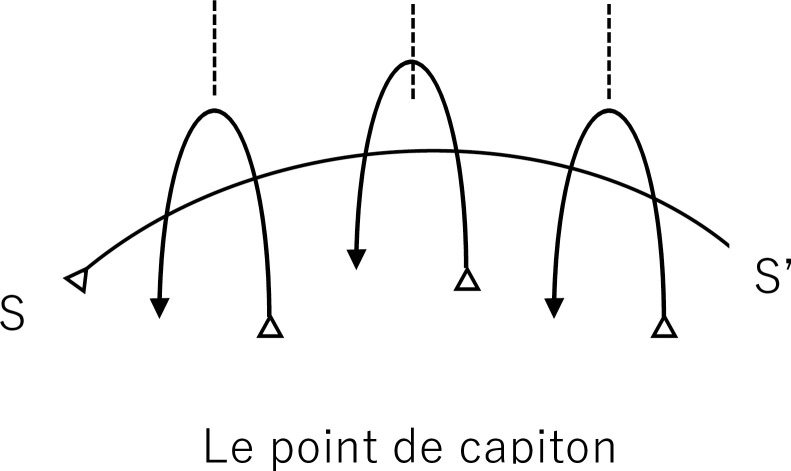
Illustration of ‘le point de capiton’.The subject sews two pieces of cloth (S and S’) together. S represent ‘signifier’ which refers to desire that leads the subject to express the sign, and S’ represent ‘signified’ which results in the signification during speech or writing. In general, S and S’ are not connected each other without ‘le point de capiton’ at appropriate intervals, which generates word salad.